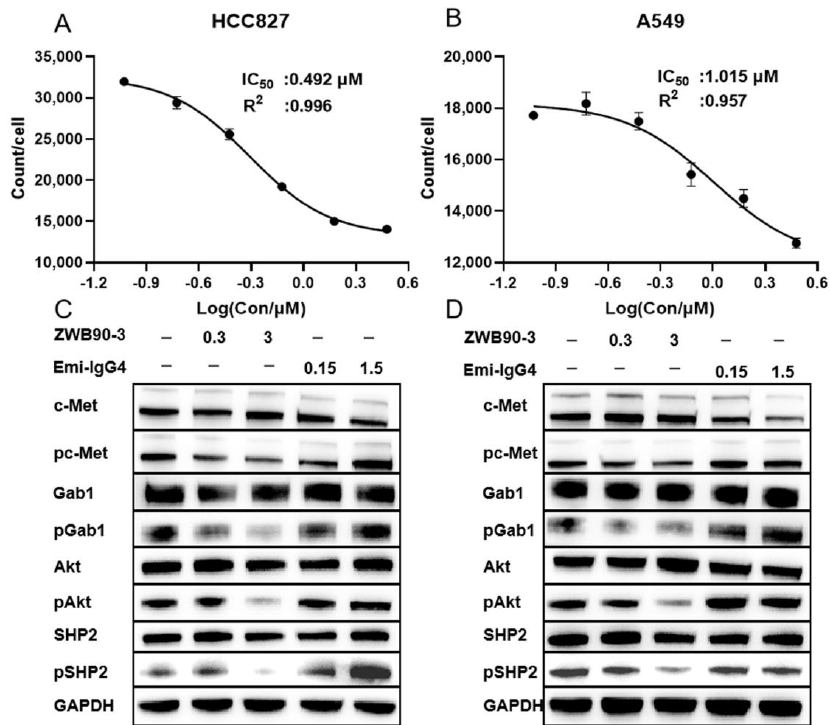
Figure 3. Effects of ZWB90-3 on the inhibition of cell proliferation and downstream signaling. ( A , B